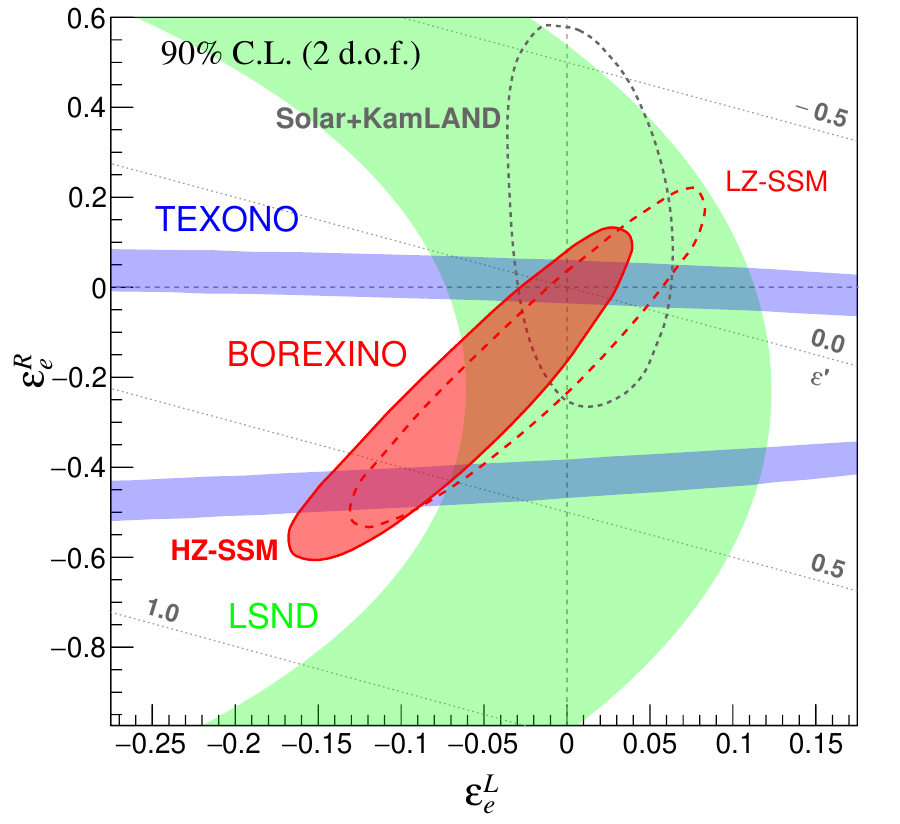
Figure 6 . Allowed region for NSI parameters in " L=R e plane obtained in the present work.